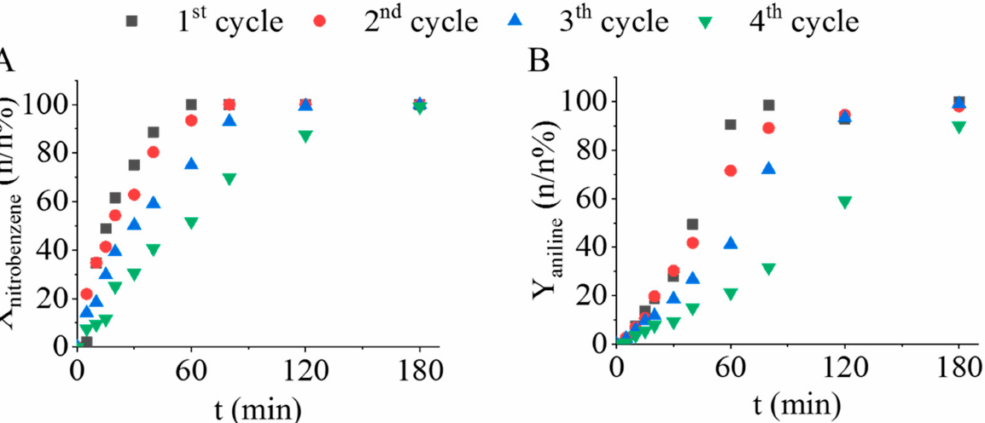
Figure 8. Nitrobenzene conversion ( A ) and aniline yield ( B ) vs. time of hydrogenation during the reuse tests of the prepared Pd/CF